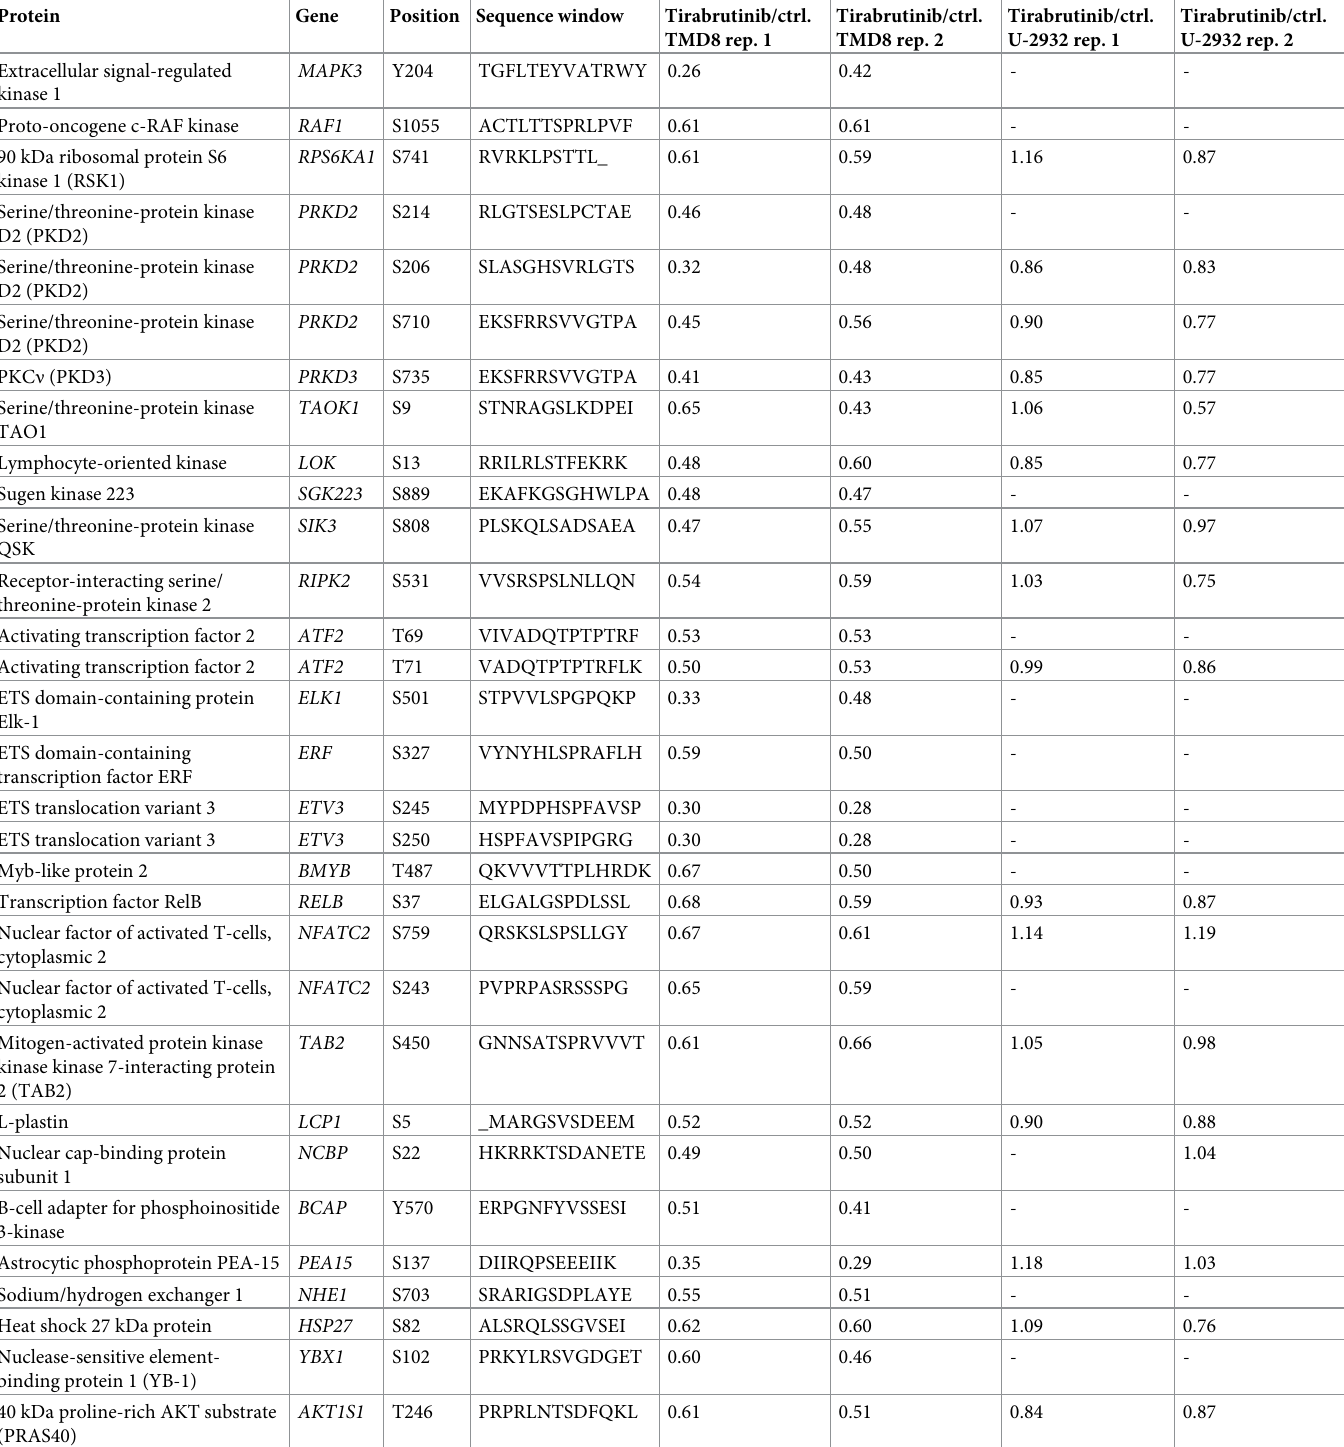
Table 3. Significantly downregulated phosphosites in TMD8 cells.